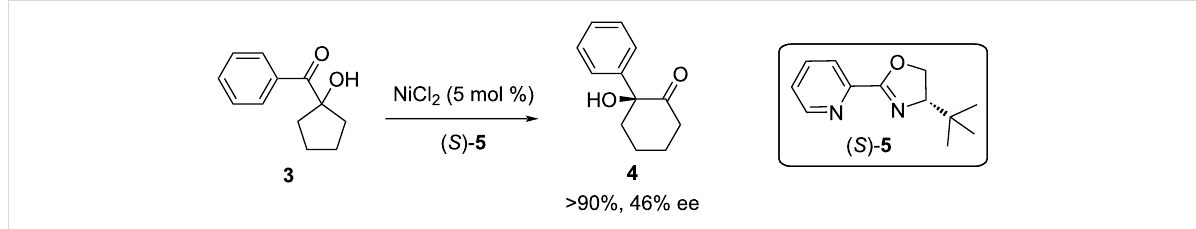
Figure 2: Nickel(II)-catalyzed enantioselective rearrangement of ketol 3 to form the ring-expanded and chiral product 4 .